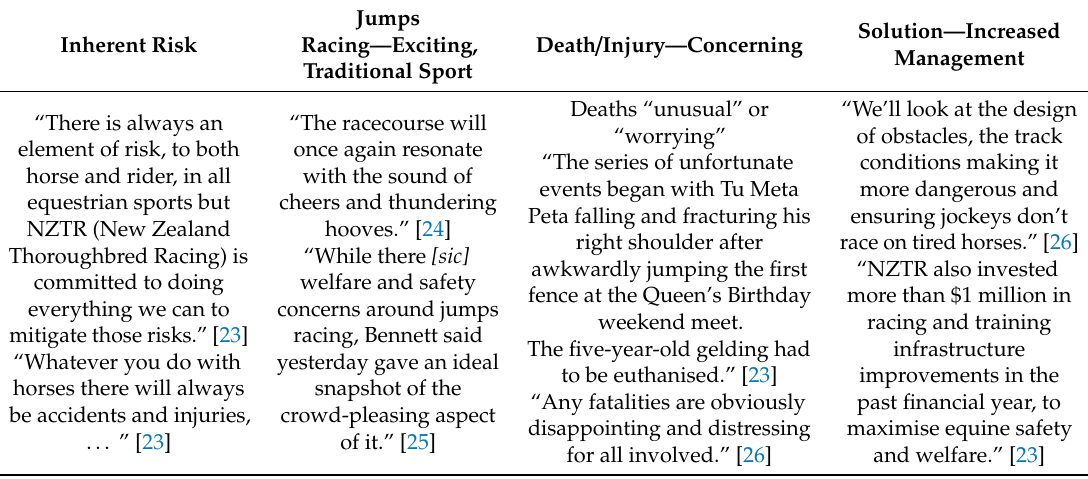
Figure 1. Number of jumps races (1st graph), number of fatalities (2nd graph), number of articles on jumps racings (3rd graph) and tone of articles covering jumps racing in New Zealand (bottom graph) from May 2016–August 2018. Table 1. Arguments from 10 articles supportive of New Zealand jumps racing published between May 2016–August